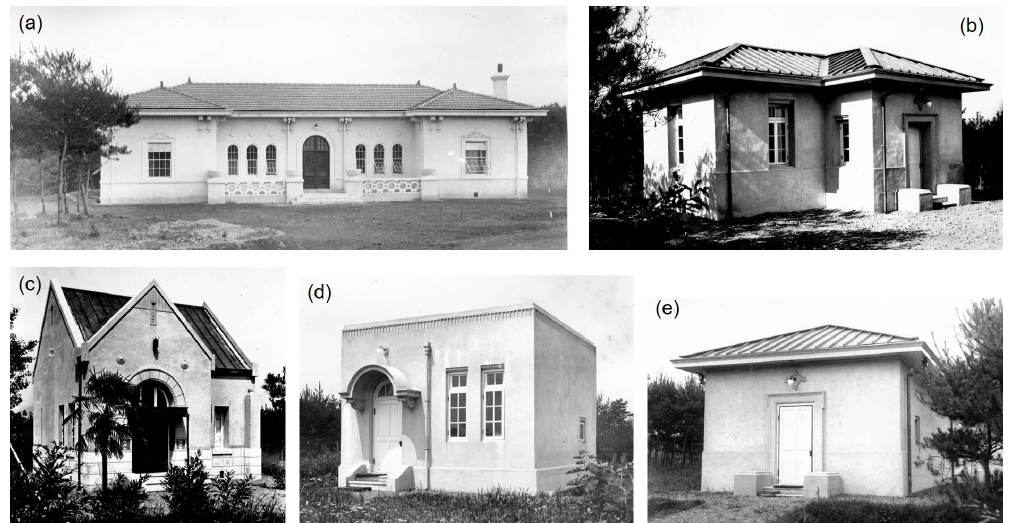
Figure 8. Buildings constructed in 1924–1925. (a) The main office, (b) the absolute hut, (c) the experiment hut, (d) the atmospheric electricity hut, and (e) the variometer hut are still used today (photo supplied by Kakioka Magnetic Observatory).